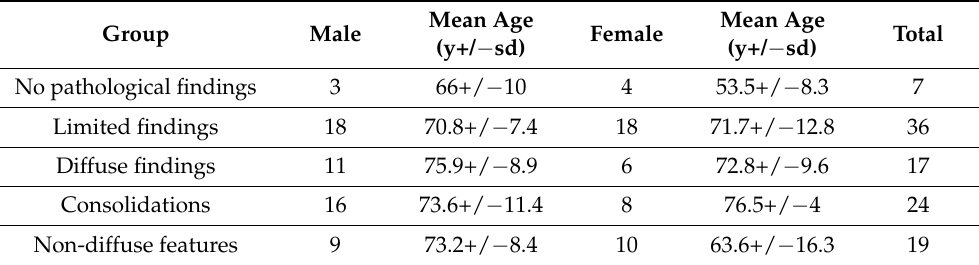
Table 2. Characteristics of patient’s